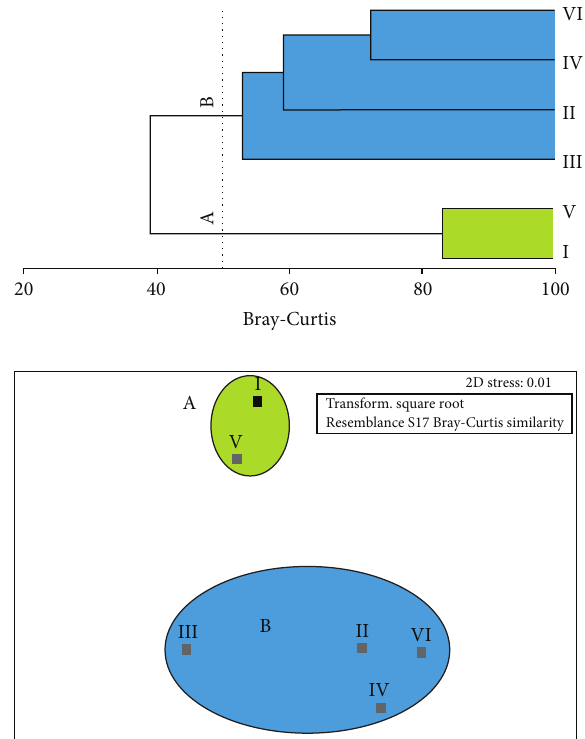
Figure 3: Cluster analysis and nonmetric multidimensional scaling (MDS) analysis of the study areas, indicating two clear groups: A, containing only areas I and V, and B, encompassing all others area (II, III, IV, and